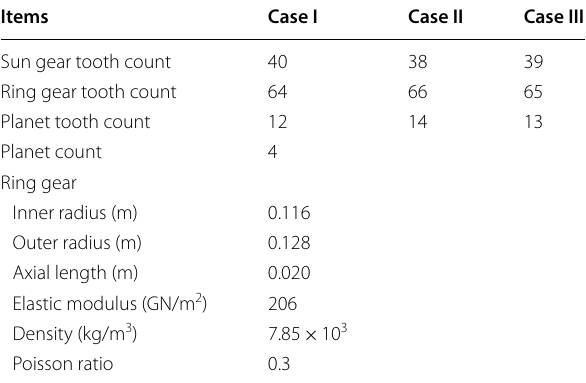
Table 8 Specifications of three sample PGT with distinct